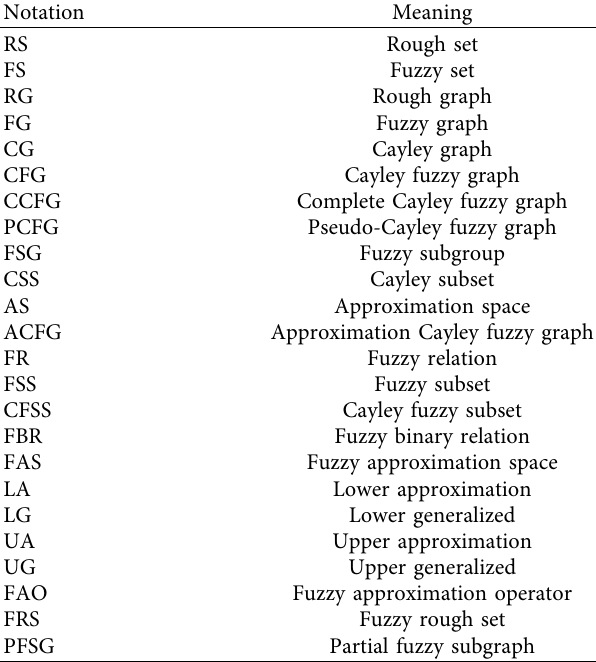
Table 1: Some basic